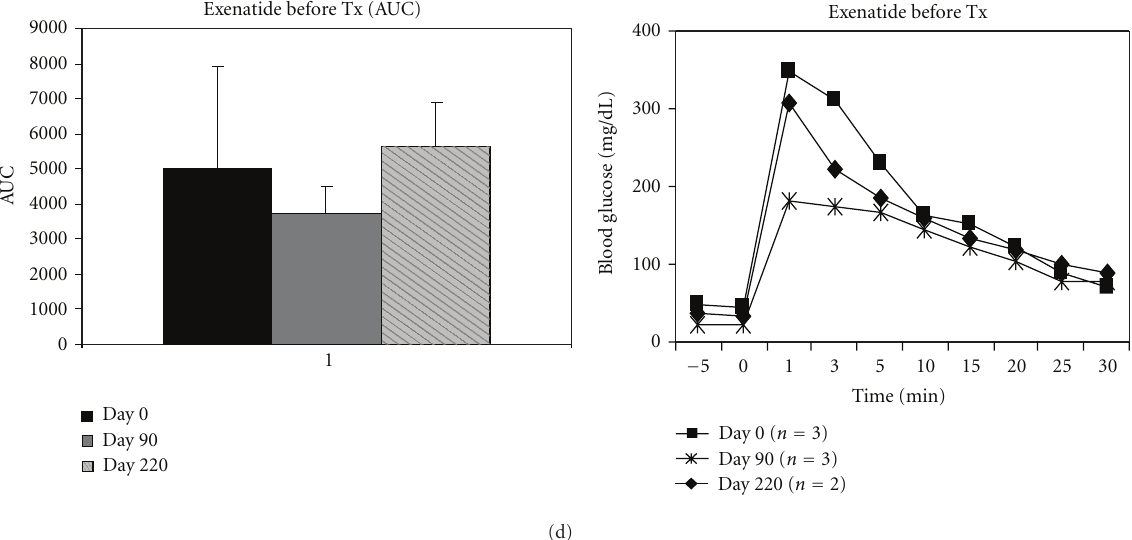
Figure 2: Blood glucose levels measured following intravenous glucose administration (IVGTT) with area under the curve measurements for glucose response for animals treated with ATG/CSA/MMF (a) or exenatide after transplant only (b), untreated (c), and pre-treated with exenatide (d). IVGTTs were performed at baseline prior to pancreatectomy, at day 10 posttransplant for untreated and postexenatide groups, and at day 90 posttransplant for ATG/CSA/MMF and exenatide pre-treatment